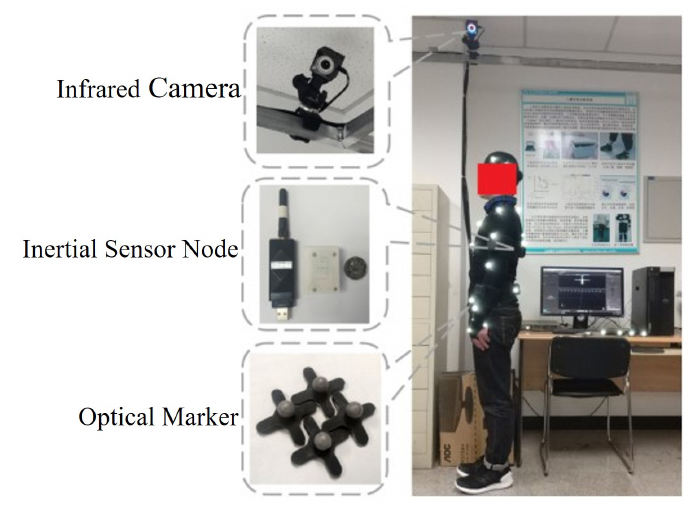
Figure 13. Contrast experimental scene between self-made system and optical capture system.